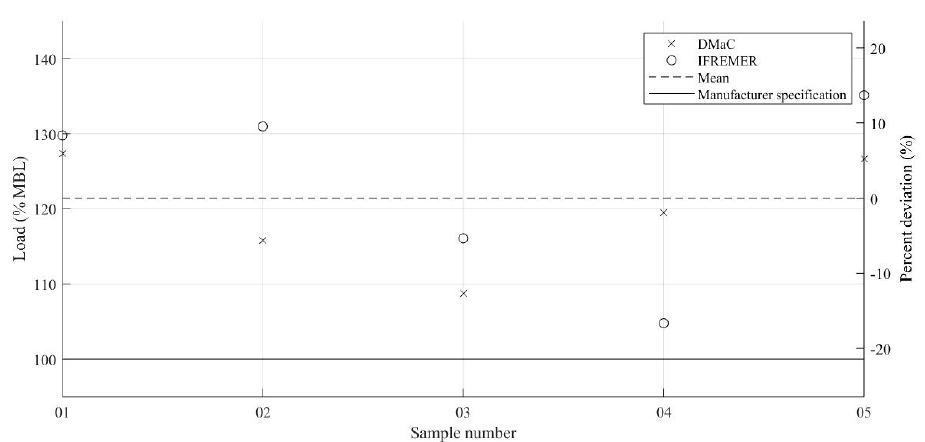
Figure 10. Load-to-failure RRT showing recorded break load and percent deviation from mean break load of 204 kN.